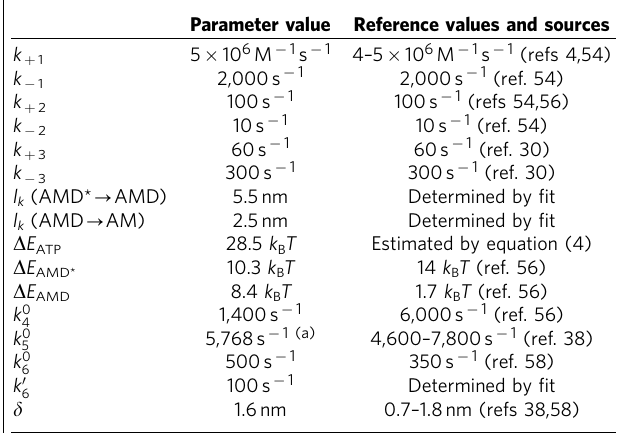
Table 1 | Parameter values in simulation